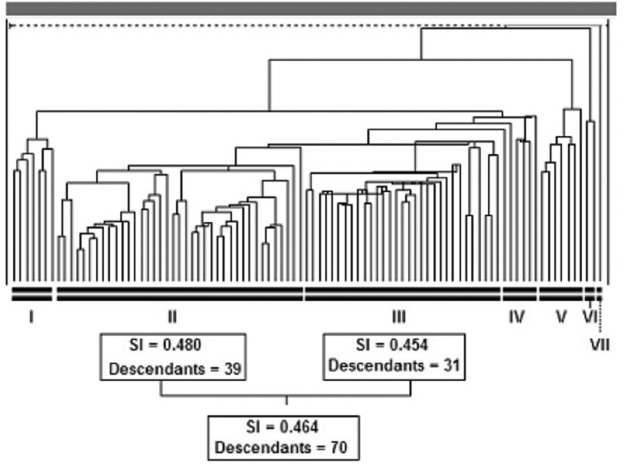
FIGURE 5 - Optimized dendrogram acquired after n-53